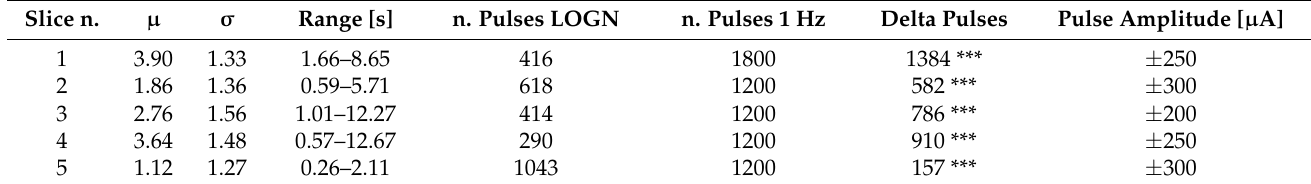
Table 1. Stimulation parameters for the dataset summarized in Figure 4. *** p < 0.0001. Slice n.